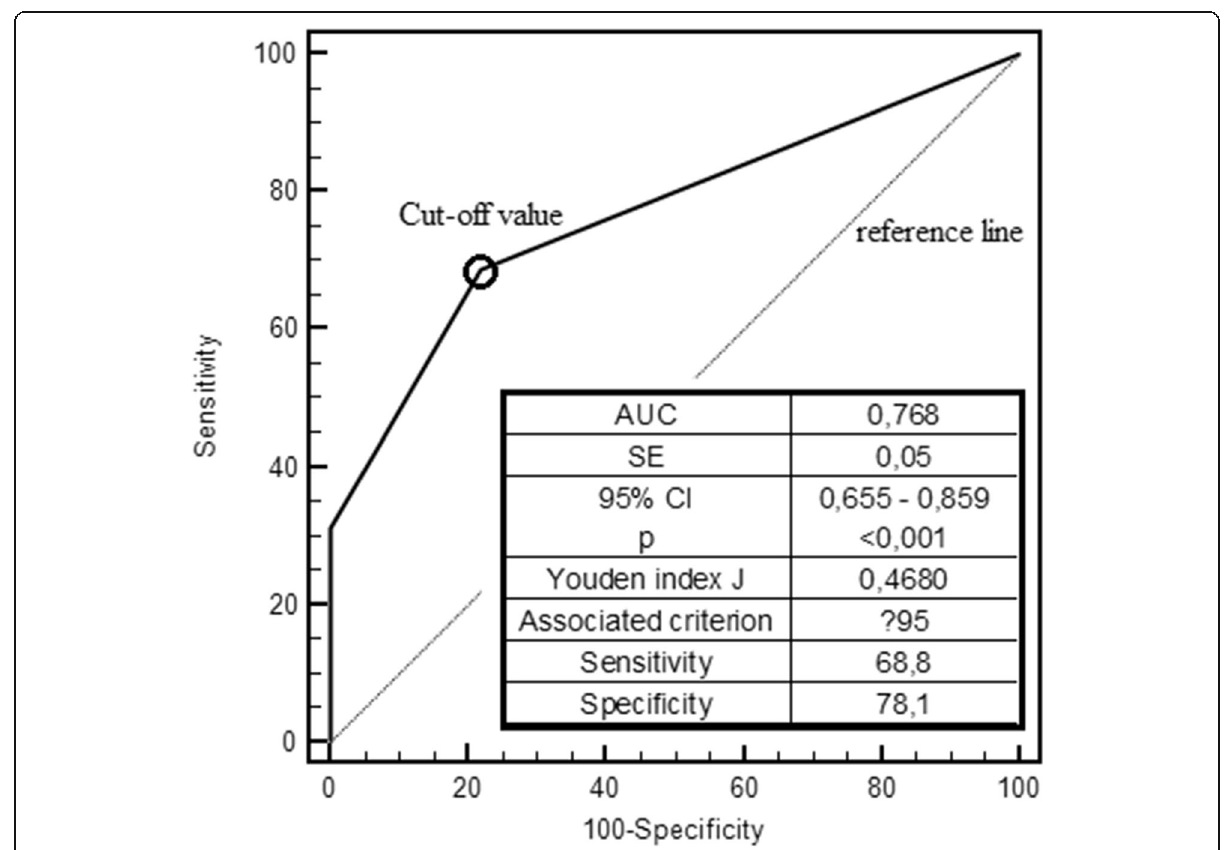
Fig. 1 Diagnostic performance assessment of Barthel Index score in HD patients with hip pain. AUC area under the ROC curve, SE standard error, CI confidence